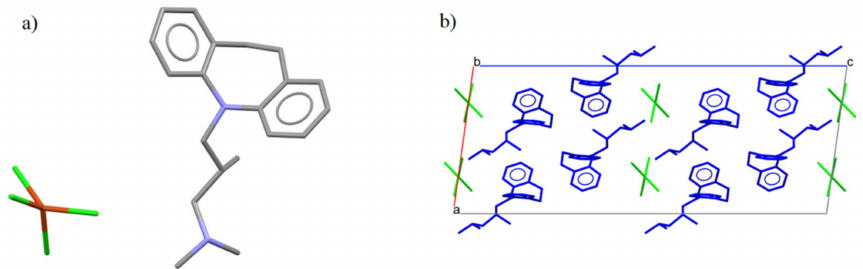
Figure 3. ( a ) The molecular structures of the AFOLOW. ( b ) Packing of the molecules in the AFOLOW along the b